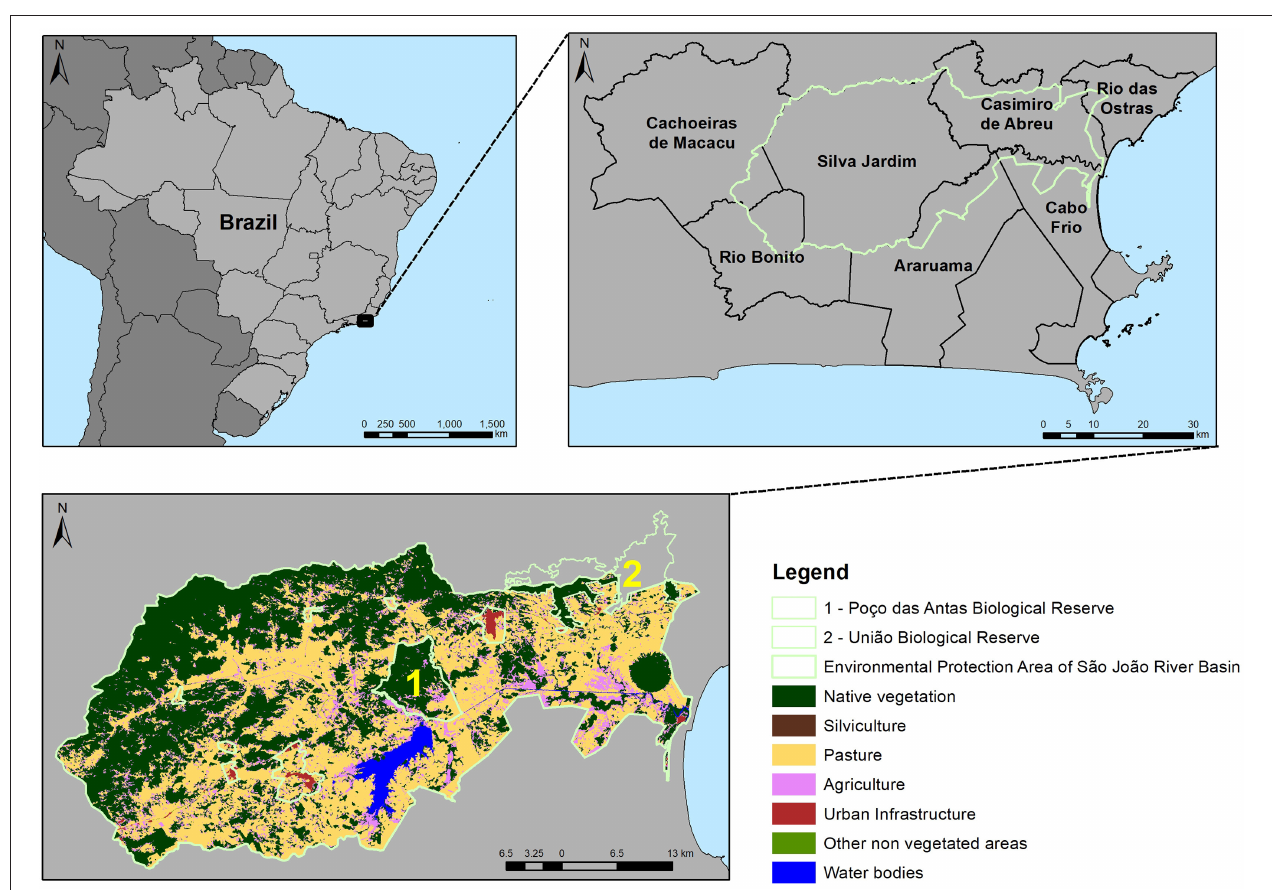
FIGURE 1 | Map showing the location of the study area in Rio de Janeiro state (Brazil), highlighting the seven municipalities included in the Environmental Protection Area of São João River Basin/Golden Lion Tamarin (APA SJ) (in light green) (map on the right), and the land use coverage throughout the APA SJ (lower map) (Elaboration: Marcus